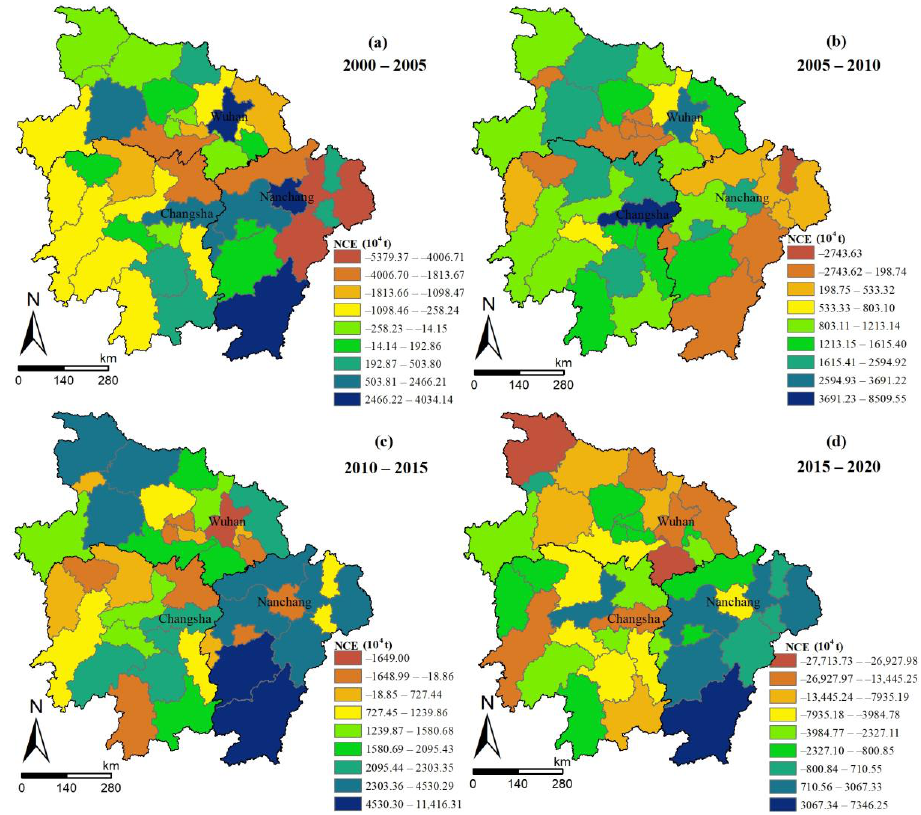
Figure 7. Changes in net carbon emissions in the Middle Reaches of the Yangtze River from 2000 to